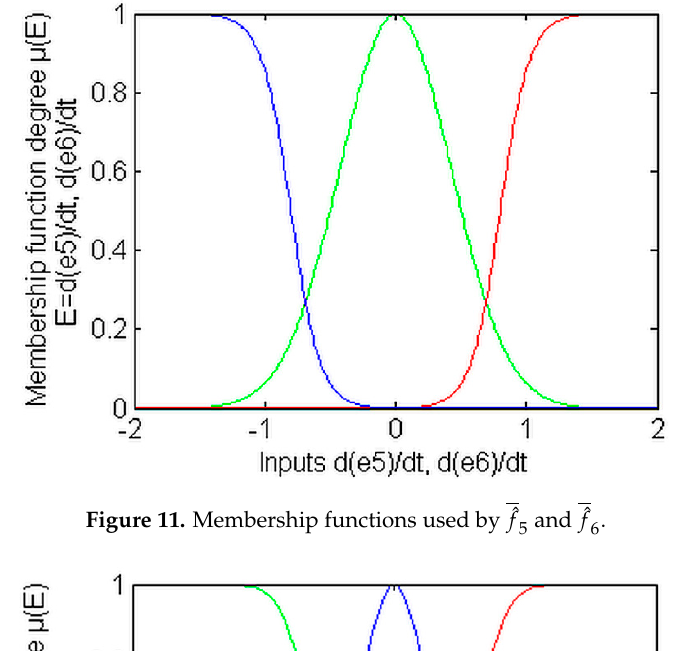
Figure 11. Membership functions used by ˆ f 5